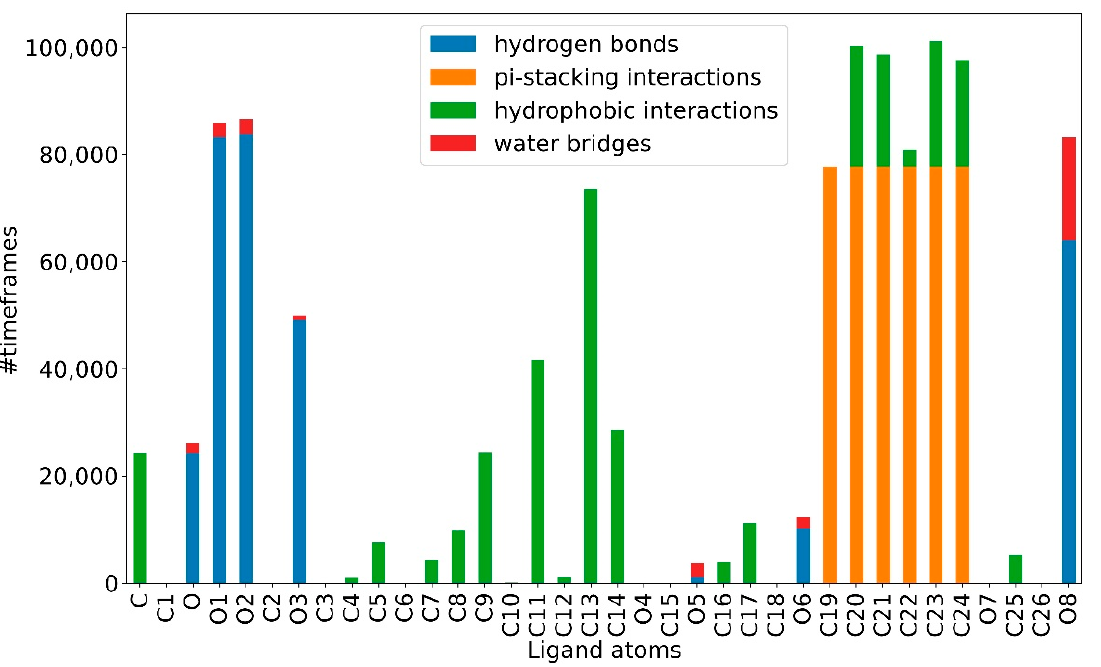
Figure 9. Type of bond established by a single atom of the c7 ligand. Table 3. Percentage of the permanence of most relevant non-covalent interactions between the atoms of the compound c6 and the amino acids or nucleotides of the receptor 1T8I.